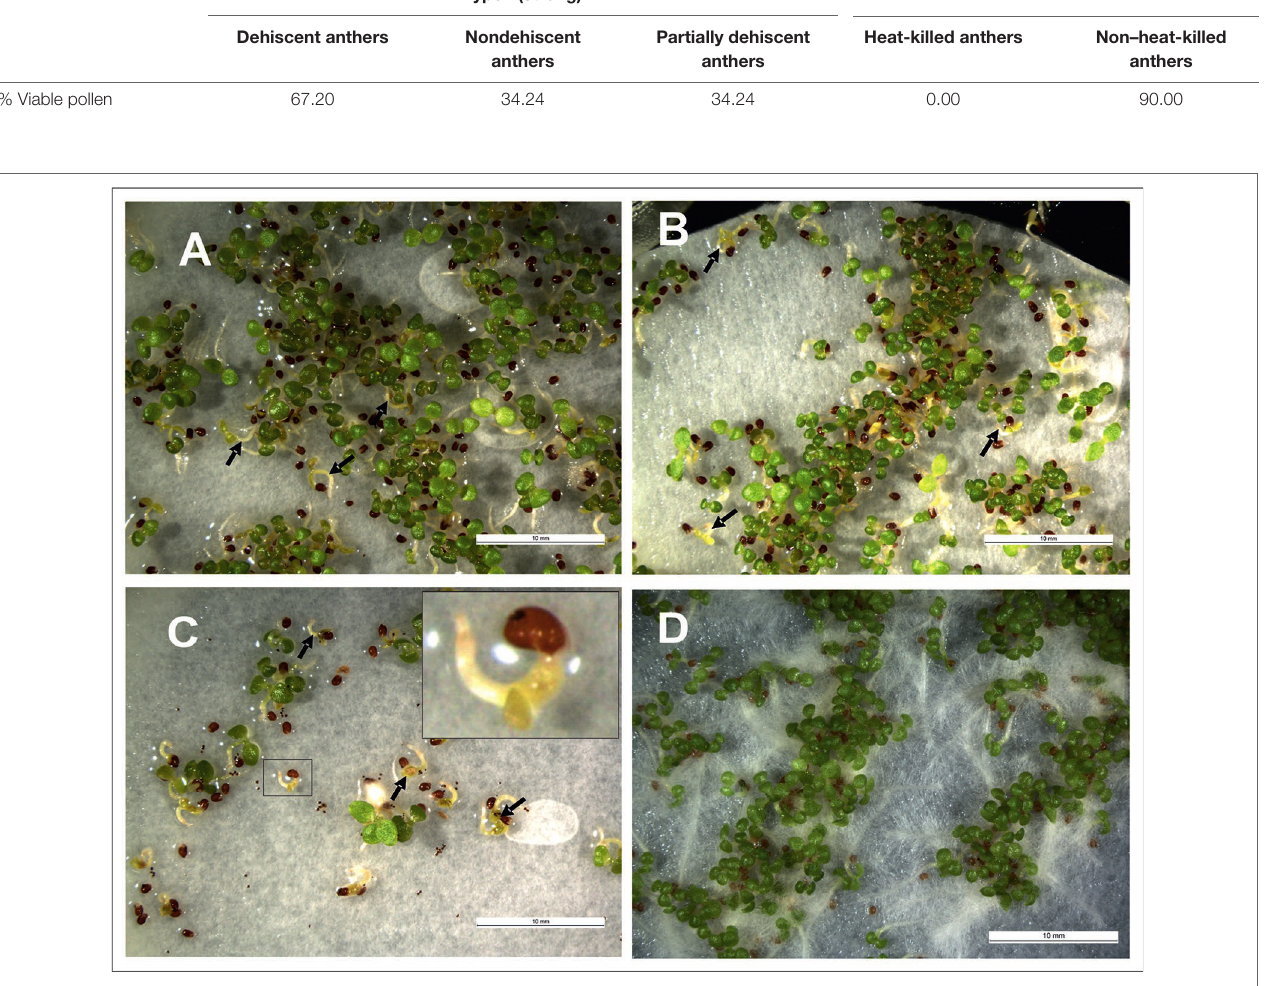
FIGURE 7 | Phenotypes of transgenic (A, B, and C, overexpressing MYB10.1 ) and WT (D) tobacco seedlings; (A) T 1 seedlings from the type II 2.2 line (selfed); (B) T 1 seedlings from the type II 10.2 line (selfed); (C) F 1 seedlings from the cross: ♀ 35S::LhG4 x ♂ 35S::MYB10.1. Arrows indicate pigmented cotyledons of transgenic tobacco